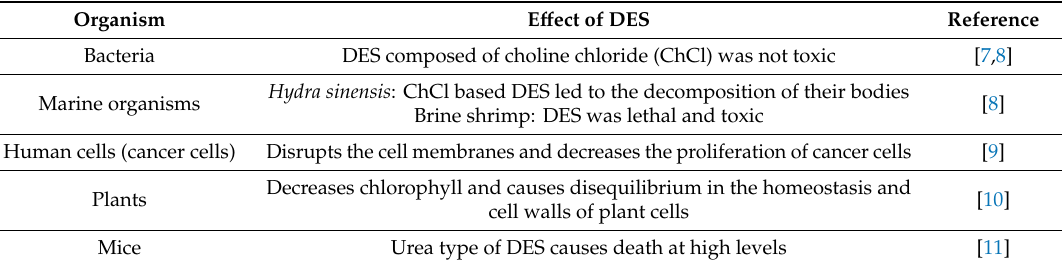
Table 1. The e ff ect of deep eutectic solvents (DES) on di ff erent organisms.